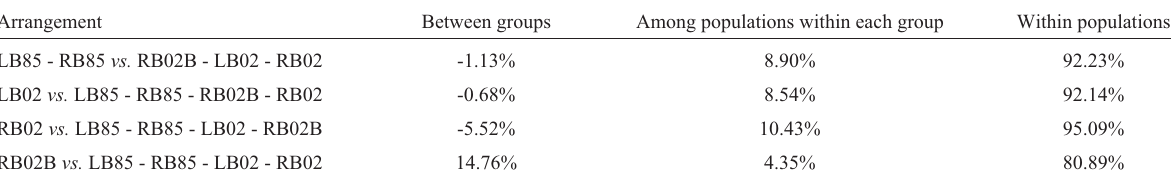
Table 5 - AMOVA results for the principal arrangements of the A. belzebul populations from Tucuruí.